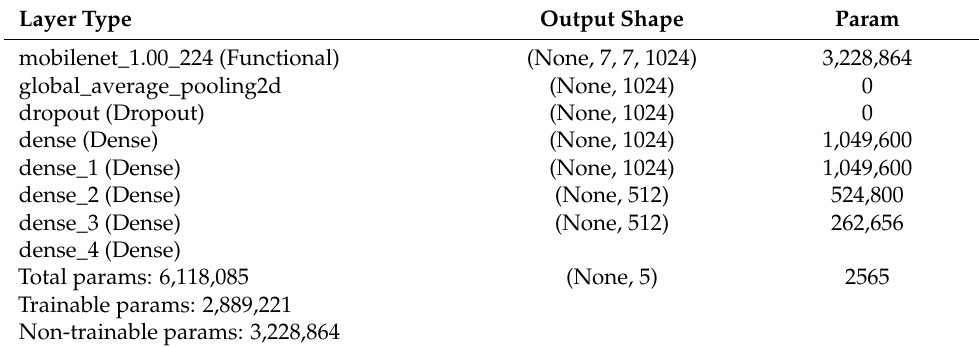
Table 2. MobileNet Transfer Learning summary.